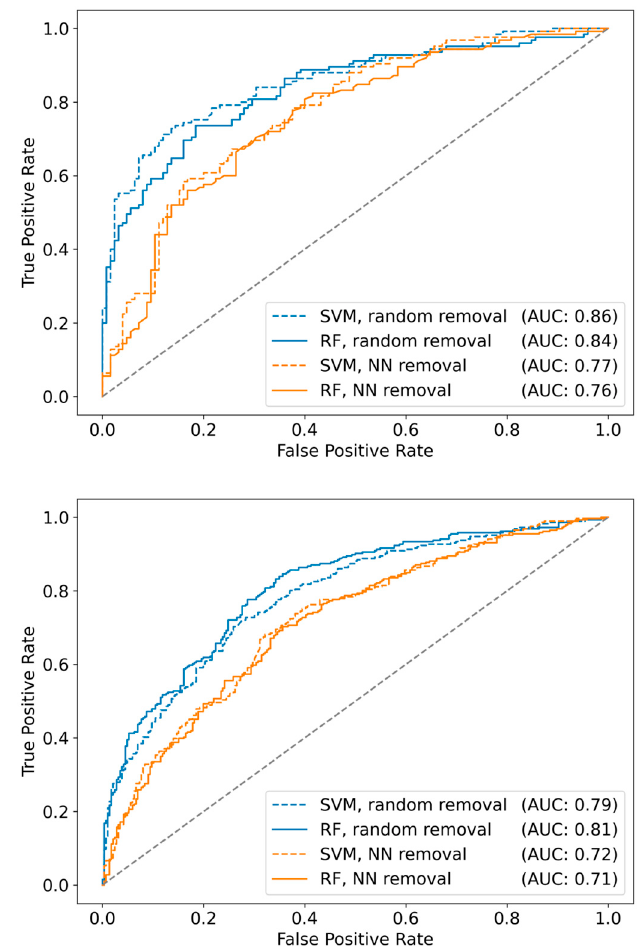
Figure 6. Receiver operating characteristic curves. For SVM and RF classification of ST- vs. MT-CPDs with random compound or NN removal, ROC curves report prediction results for the first compound data split. In ( a , b ), results are shown for data sets from biochemical and mixed assays, respectively.3.9. Predictions for Compounds from Mixed Assays